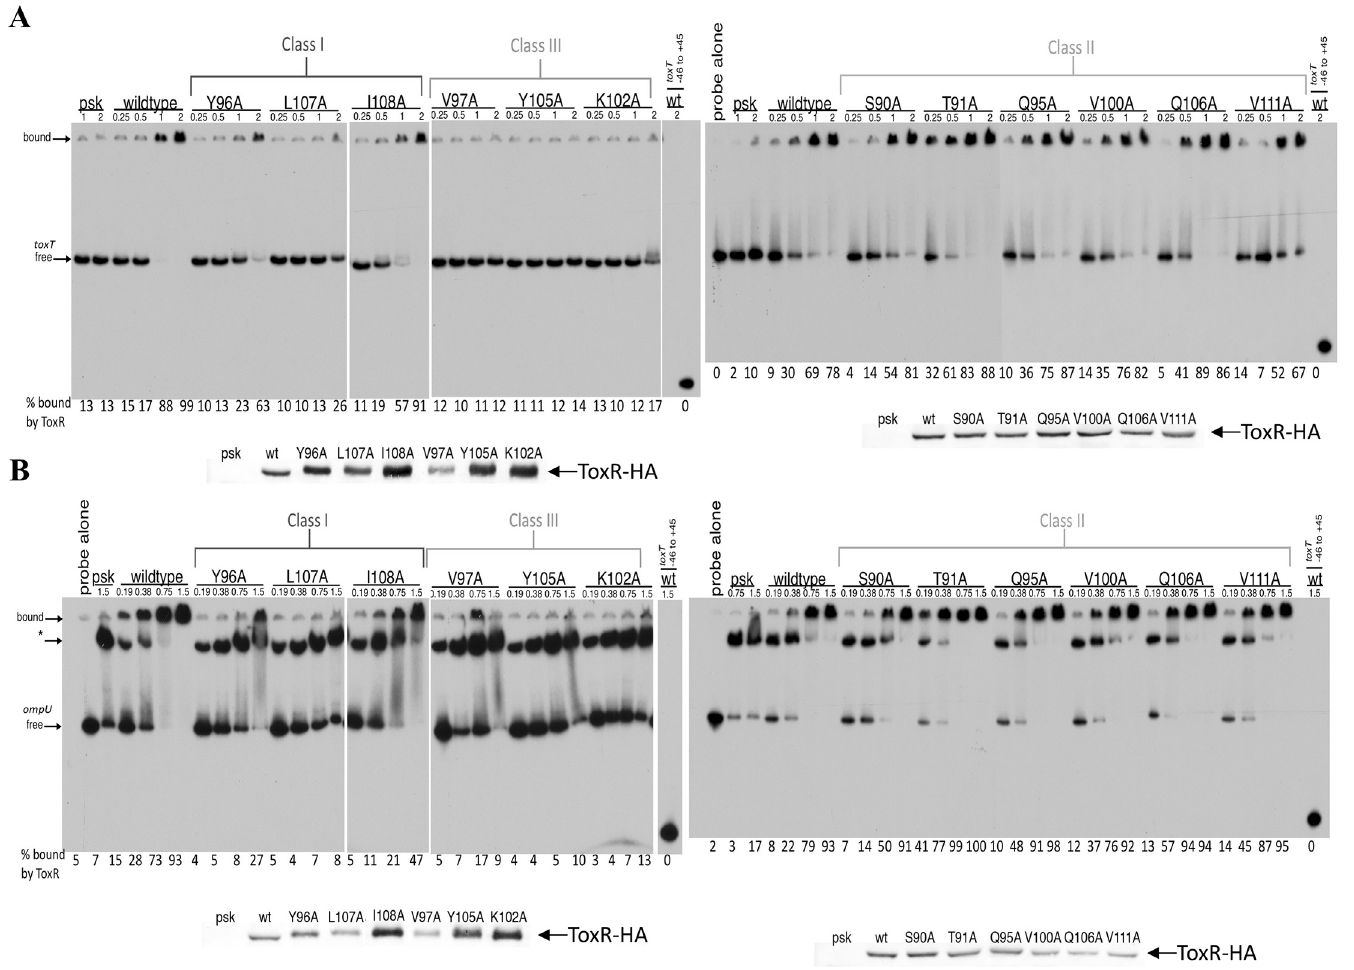
Fig 5. Several wing residues of ToxR are required for DNA binding. DNA binding by ToxR wing mutants was monitored using EMSA. V . cholerae membranes containing the ToxR wing mutants, but lacking TcpP, were bound to 32 P end-labeled probes containing either the toxT promoter (A) or the ompU promoter (B). ToxR levels in each membrane preparation was monitored by anti-HA Western blot. Representative gels and quantification are shown from a minimum of two replicates. � indicates an intermediate ToxR-independent shifted ompU promoter that is also present with the pSK vector control extract [26].